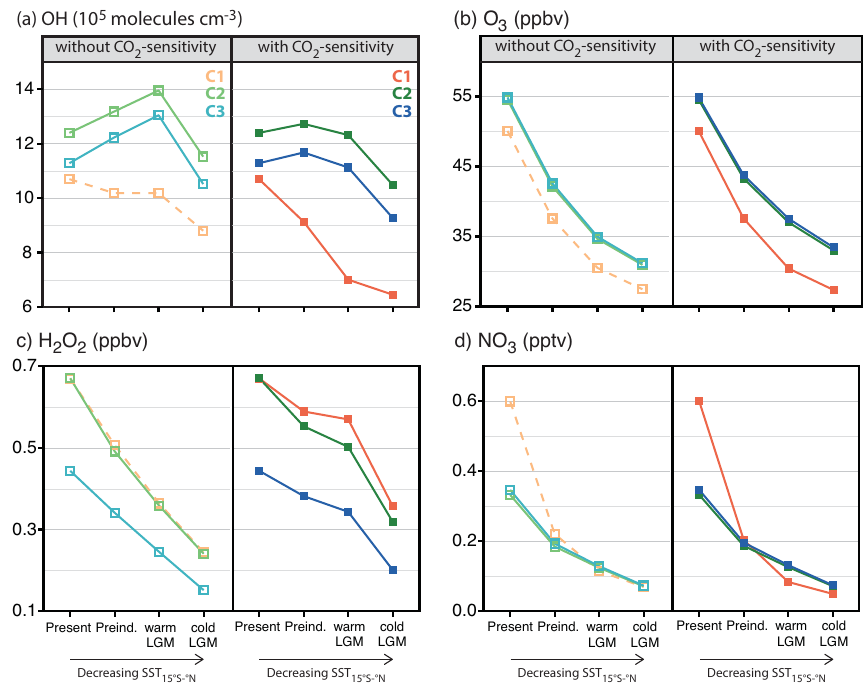
Figure 2. Simulated sensitivity of the tropospheric mean mass-weighted oxidant burdens of OH, O 3 , H 2 O 2 , and NO 3 to each combination of climate, chemistry, and plant isoprene emission scheme. Simulations are as described in Table 2. The climate scenarios are present day, preindustrial, warm LGM, and cold LGM, with decreasing sea surface temperatures within 15 ◦ of the Equator (SST 15 ◦ S − ◦ N ), going from left to right along the abscissa. The chemistry schemes are C1 (orange curves), C2 (green), and C3 (blue). Plant isoprene emissions are modeled without (light shaded) or with (dark shaded) sensitivity to atmospheric CO 2 concentrations. The tropospheric burdens are calculated with the tropopause determined from the thermal lapse rate. The dotted light-orange line represents the results reported in Murray et al. (2014) for their “best estimate” lightning and fire emissions